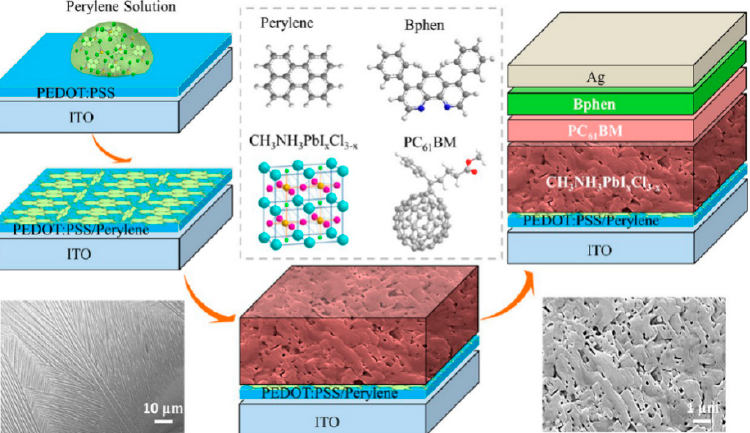
Figure 8. Chart flow of the device fabrication of a planar PSC and the molecule structures of the materials used in the device. Bottom left: SEM image of branch-shaped perylene films. Bottom right: SEM image of fabric CH 3 NH 3 PbIxCl 3 − x films deposited on the branch shaped perylene underlayer. Copyright Reproduced with permission from Ref. [76].